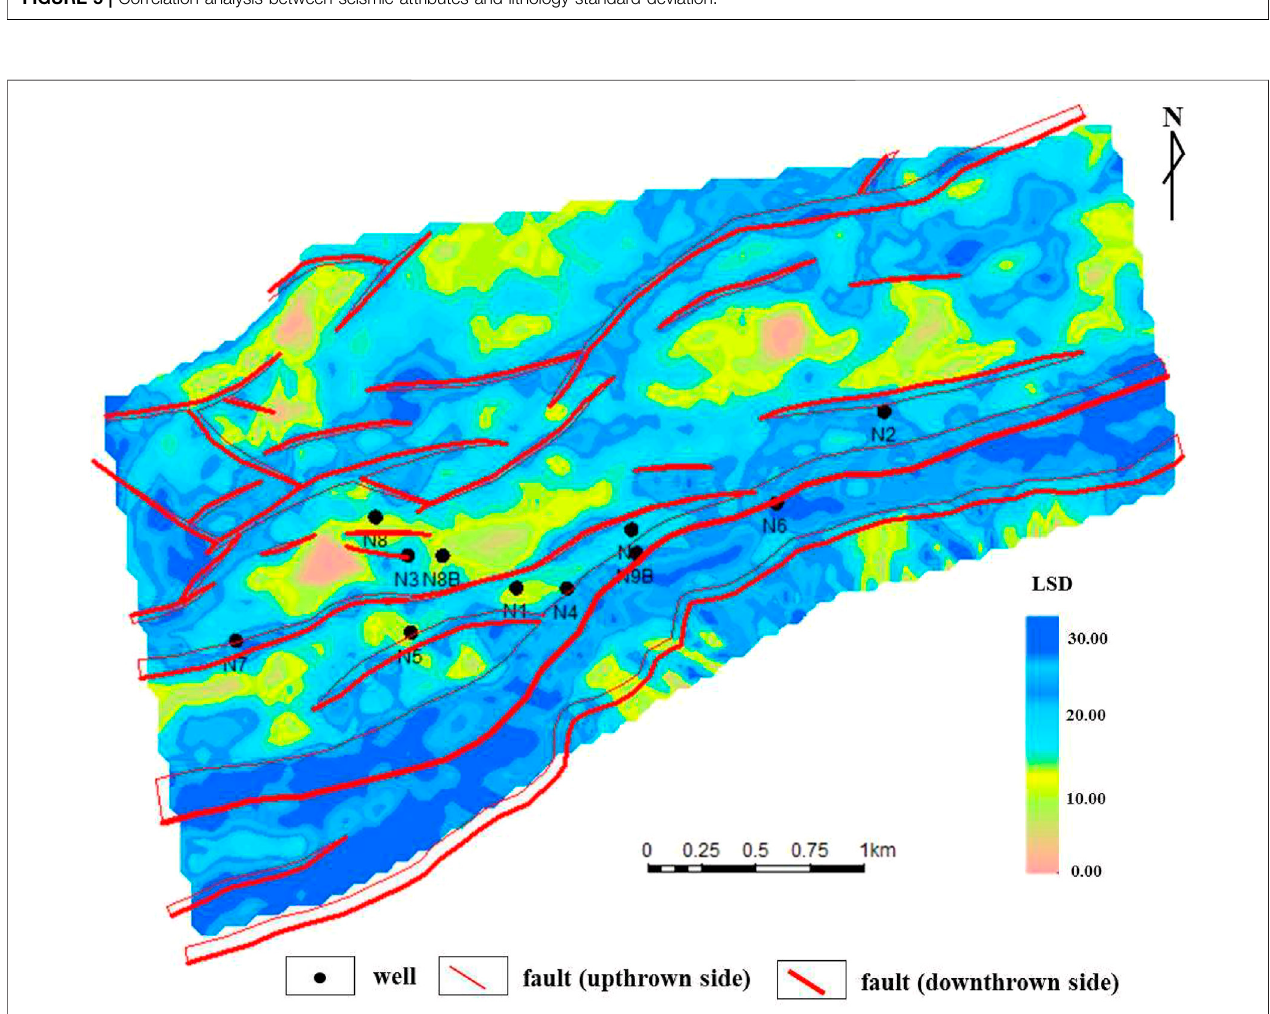
FIGURE 6 | Lithology standard deviation (LSD) plane distribution of the Weizhou 1 – N oil fi eld.